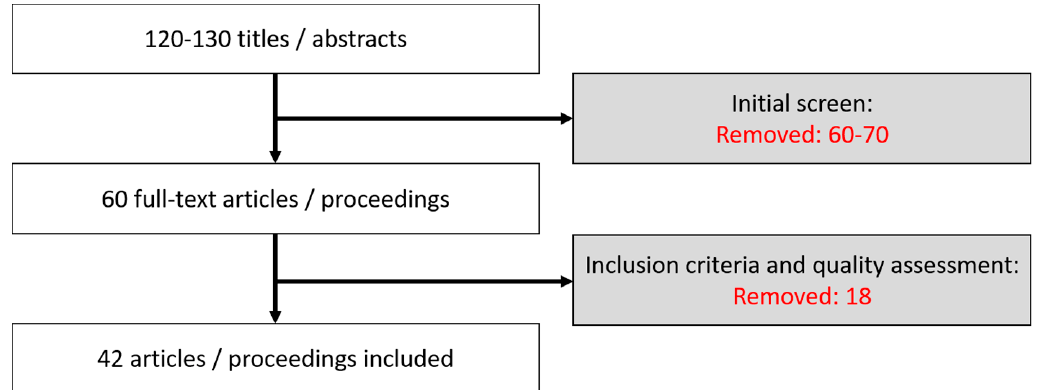
Figure 1. Screening process of a systematic literature review .